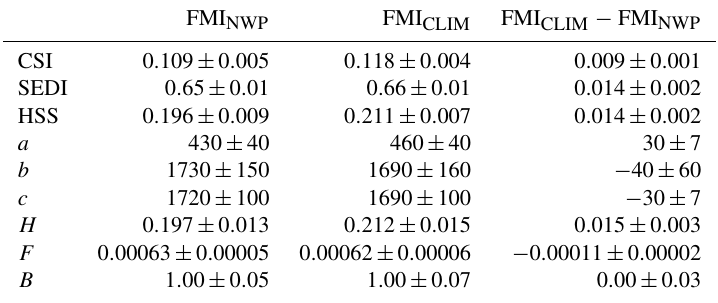
Table 2. The cross-validation measures and scores in 7-year validation periods when the predicted 6h FZRA result is compared with observed 6h events. Mean values and standard errors, computed for validation periods using the sample variance of period values, are shown. See text and Appendix A for definitions of measures and scores.